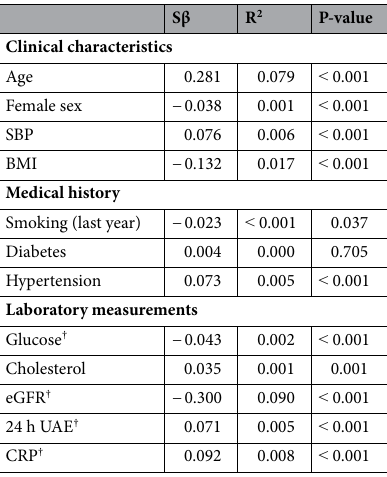
Table 2. Relationship between DKK3 levels and baseline characteristics. Sβ standardized beta coefficient. Other abbreviations as in Table 1. †